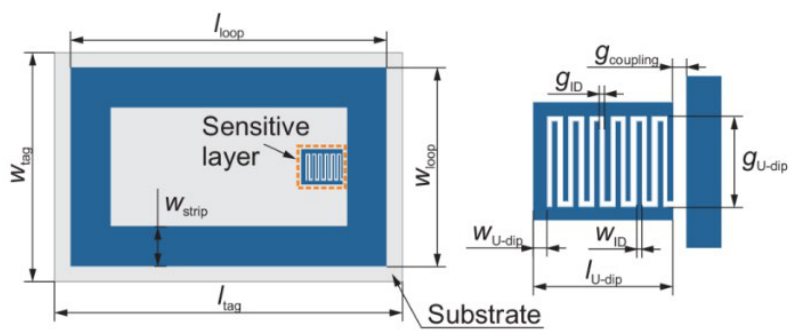
Figure 10. Sketch of IC U-dipole coupled in the metallic loop sensor tag.